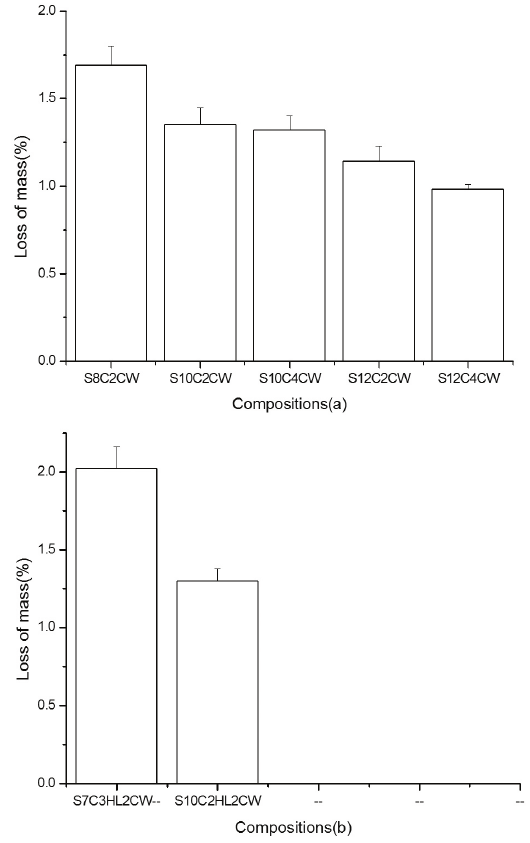
Figure 8. Mass loss of soil-cement-lime and CW solid bricks (a) and